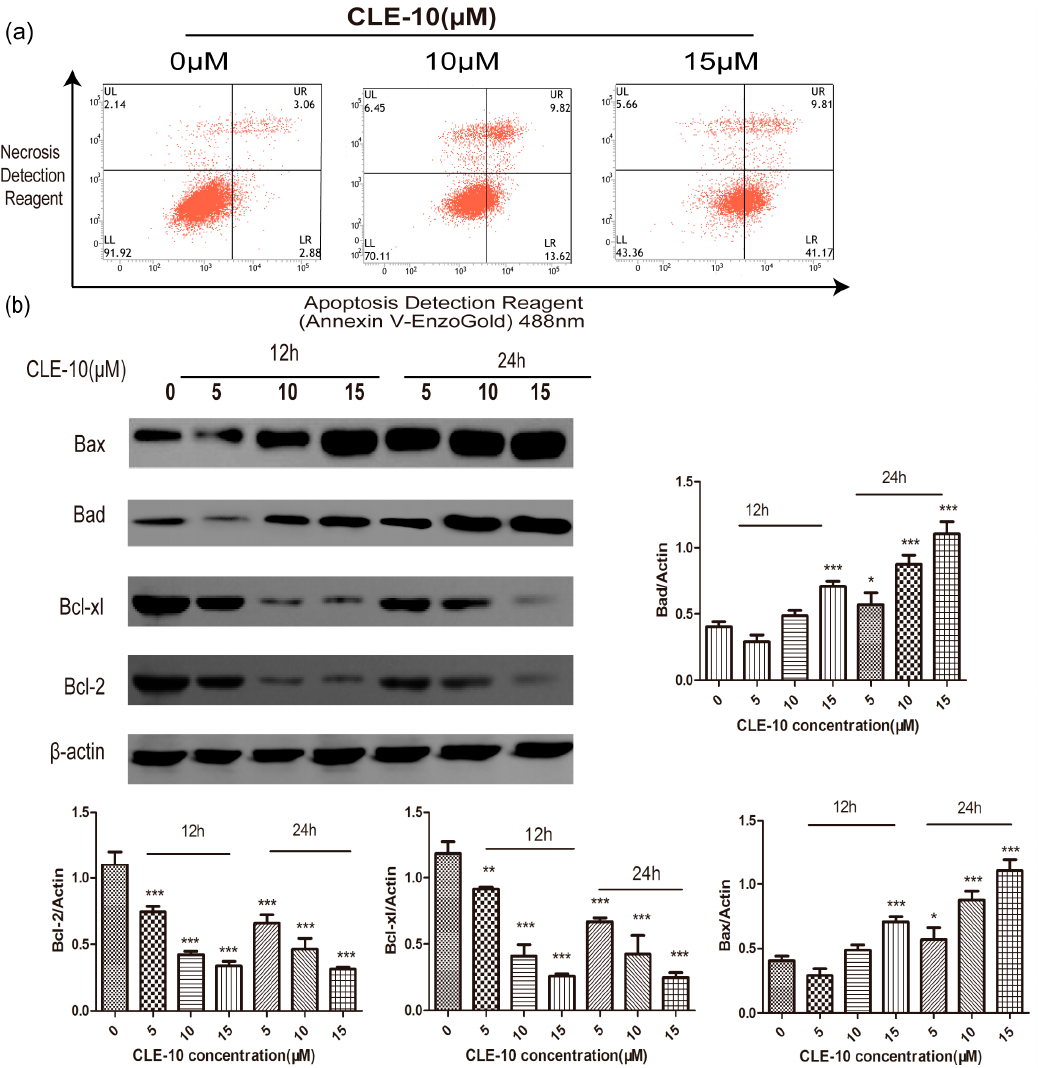
Figure 4. CLE-10 induced apoptosis in MDA-MB-231 cells. ( a ) Apoptosis induced by CLE-10 (0, 10, 15 µM) in MDA-MB-231 cells was detected by flow cytometry. ( b ) Representative Western blotting bands of Bcl-2, Bcl-xl, Bax, and Bad in MDA-MB-231 cells. Next to the bands are protein expression levels (* p < 0.05, ** p < 0.01, *** p < 0.001 compared with the 0 µM CLE-10 group).